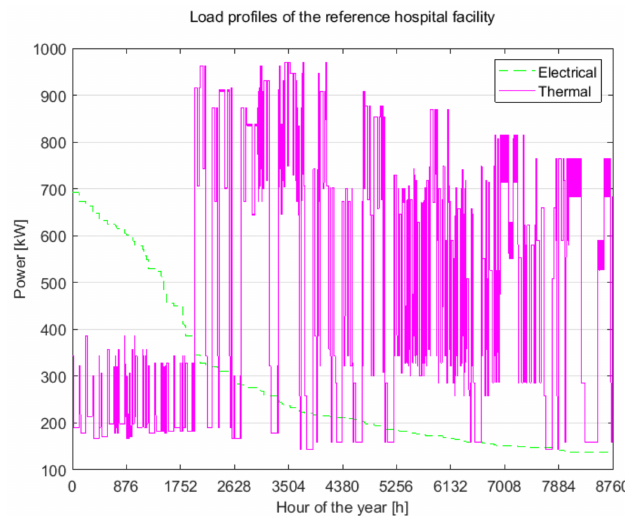
Figure 3. Annual duration curve of the electrical load and contemporary thermal load profiles of the analyzed hospital facility.